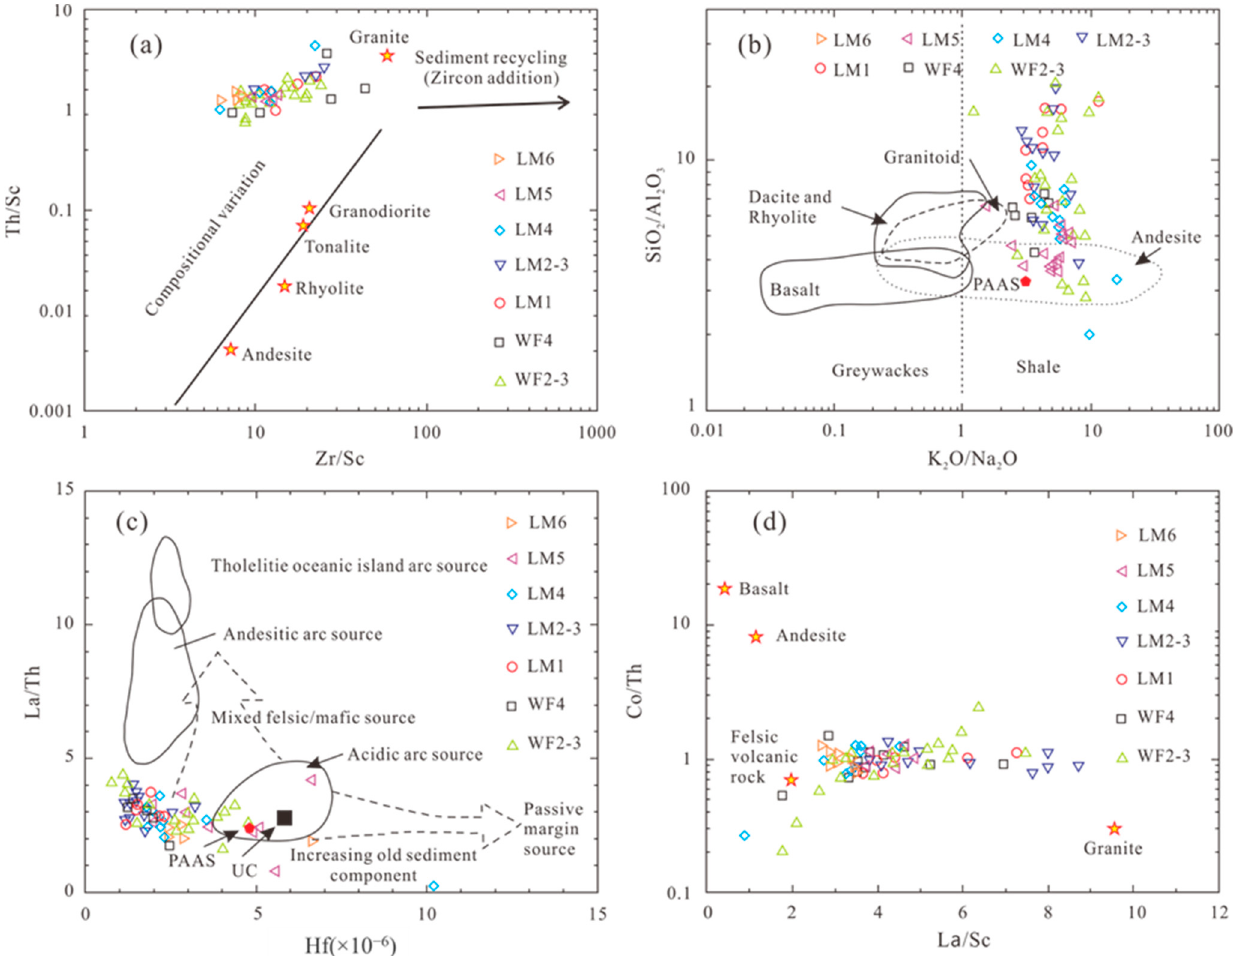
Figure 12. ( a ) Al–Ti–Zr triangular diagram [55]; ( b ) La/Sm–Th, ( c ) Tb/Yb–Hf, and ( d ) Ta/La–Ti biva- riate diagrams [56] showing the effects of sedimentary sorting. In the figure, CAS refers to the field of calc-alkaline suites, and SPG refers to strongly peraluminous granites.